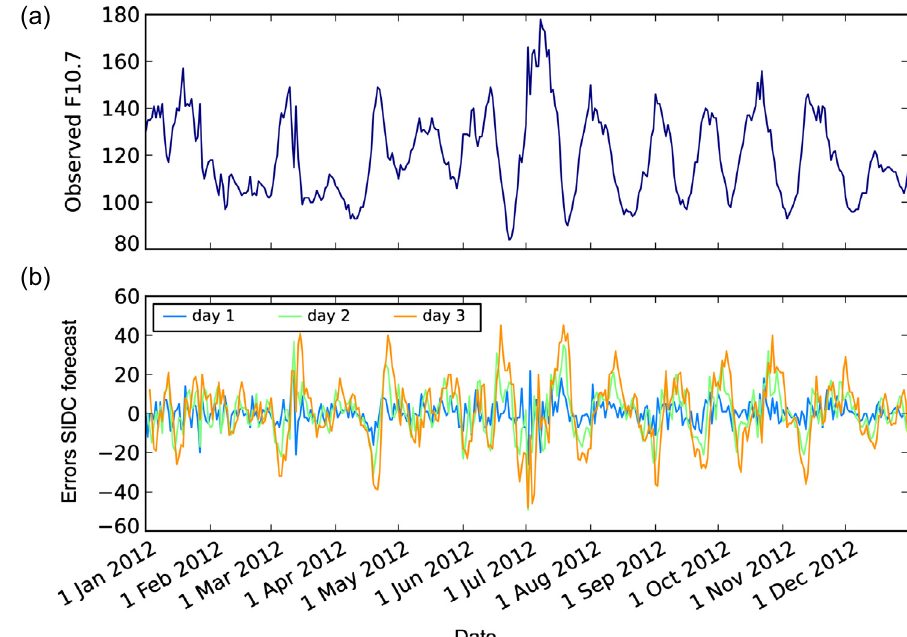
Fig. 1. Evolution of observations (a) and errors of the daily SIDC forecast (b) for days 1–3 of the F10.7 radio flux during year